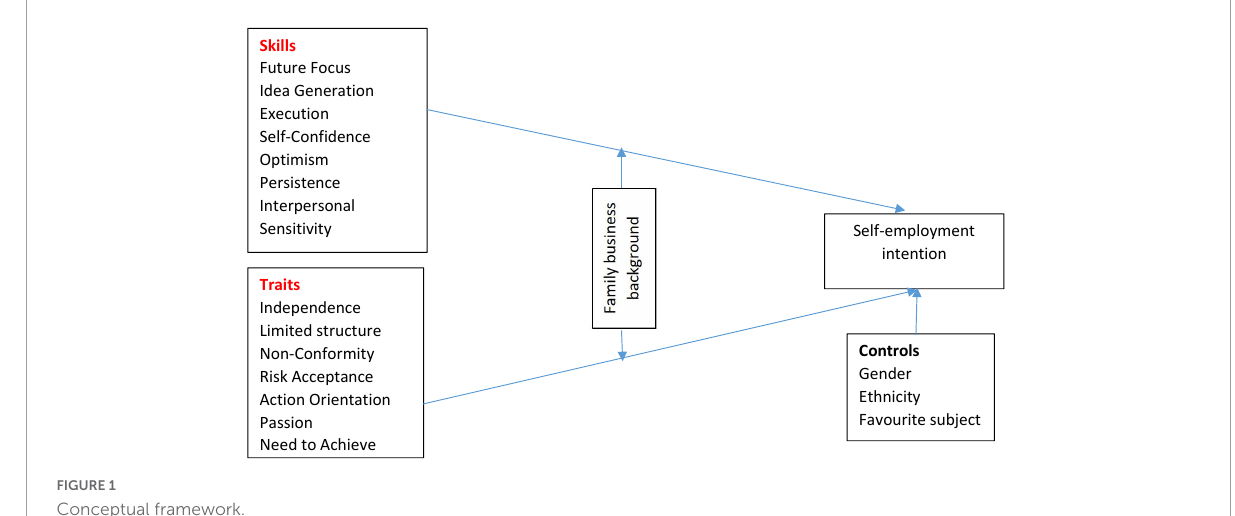
FIGURE1 Conceptual